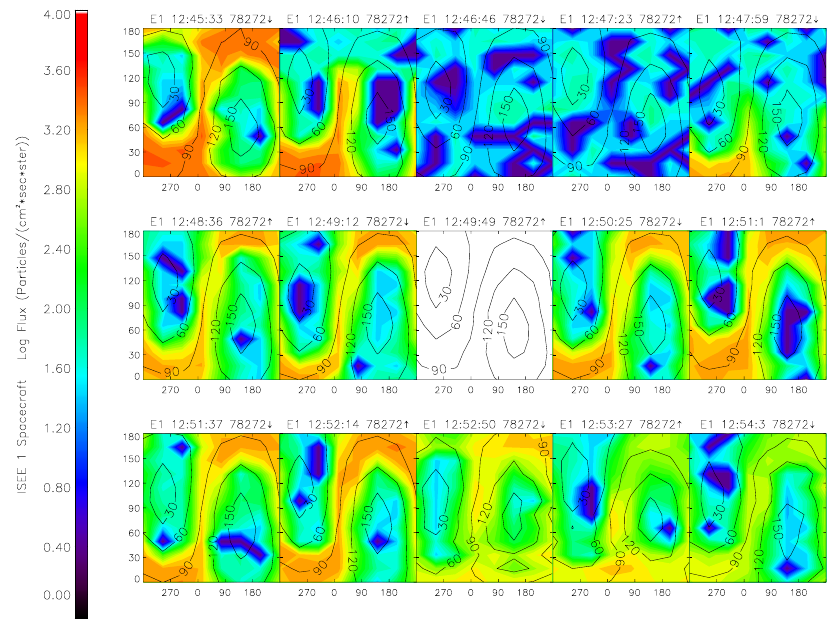
Fig. 6. Electron flux presented similar to Fig. 4, but for the time period 12:45:33–12:54:03 UT. Zone 3, which began on the previous figure ends during the second panel on the top row. Panels 3–5 (12:46:46–12:47:59 UT) then correspond to the region of increased magnetic field strength between zones 3 and 4. Zone 4 starts in the last panel of the first row and then continues into Fig. 7.